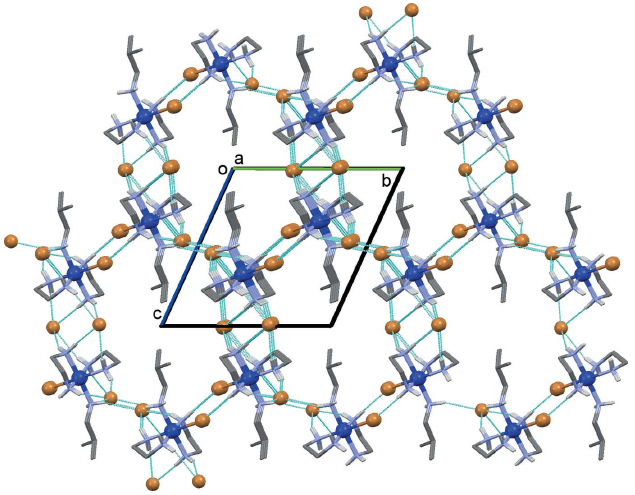
Figure 2 The crystal packing of the title compound, viewed along the a axis, showing the N—H (cid:3)(cid:3)(cid:3) Br hydrogen bonds (see Table 1) as dashed lines. Only the N-bound H atoms have been included.